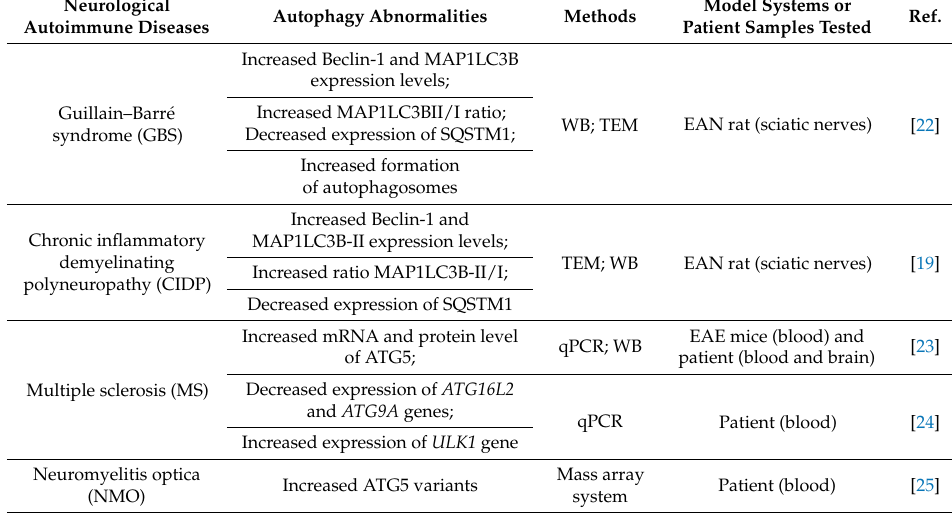
Model Systems or Patient Samples Tested